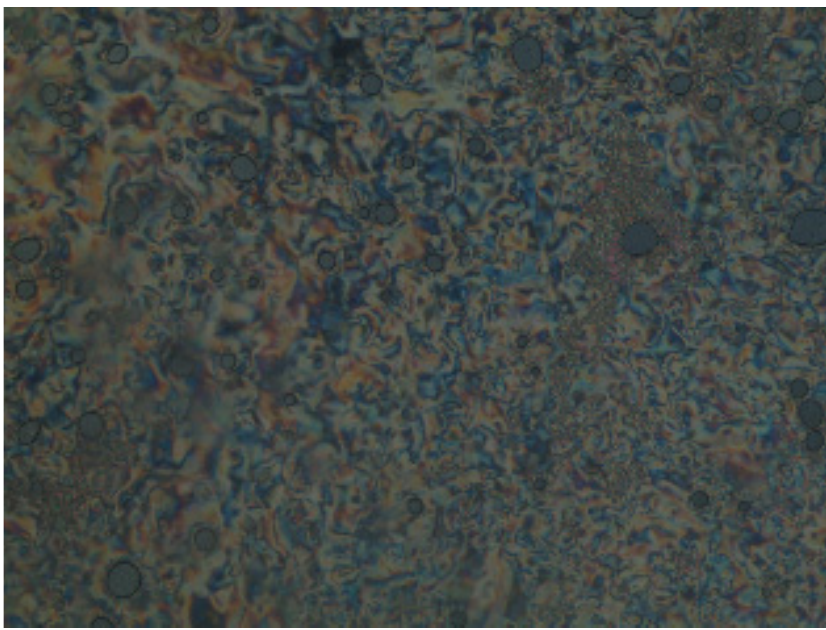
Figure 1. The second heating and cooling scan of compound I 5 provided DSC cycles with a heating rate of 10 °C min − 1 .